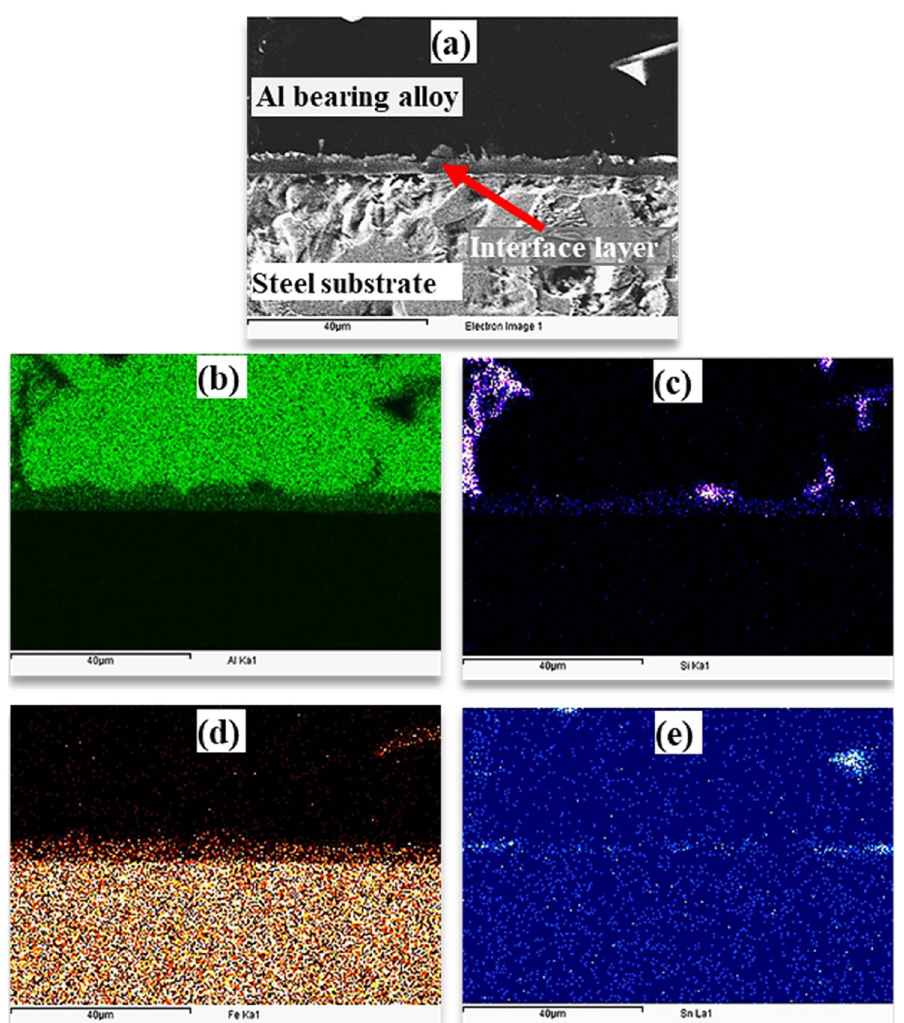
Figure 9. ( a ) SEM images of interfacial aluminum/steel bimetal using pure tin interlayer (S1) and ( b – e ) mapping analysis of Al, Si, Fe, and Sn elements, respectively.